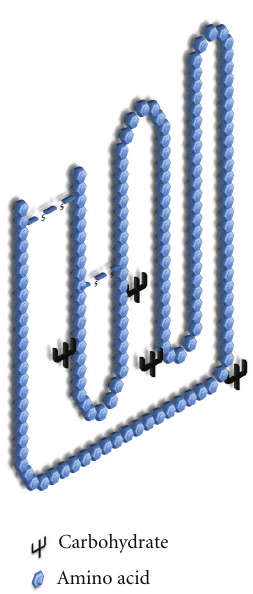
Figure 1: A schematic representation of the molecule of EPO. Adapted from Elliott et al. [25]